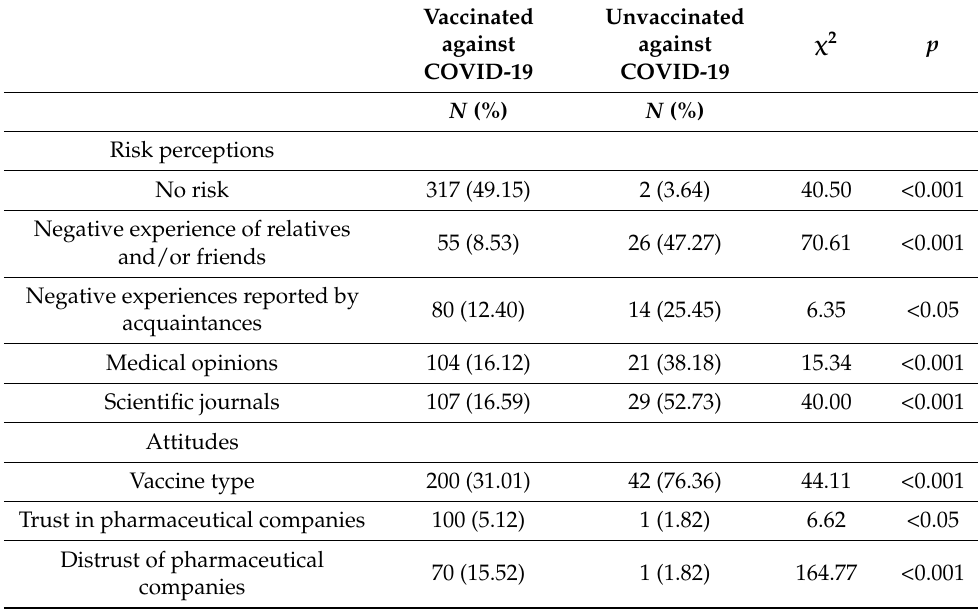
Table 3. Differences in risk perception and factors influencing attitudes toward vaccination between the vaccinated against COVID-19 and the unvaccinated